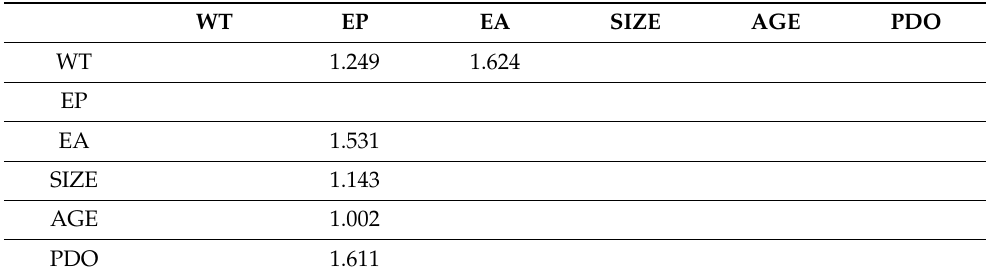
Table 5. Analysis of collinearity in the model through VIF